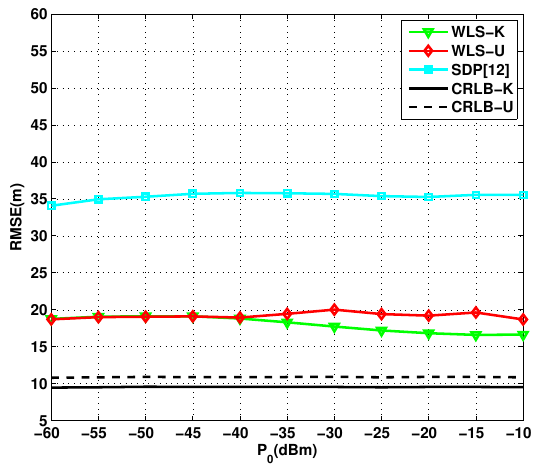
Figure 8. RMSE versus transmit power P 0 when σ = 4 dB, α f = 0.01 dB/m ( f = 34kHz), N = 10, and ρ =